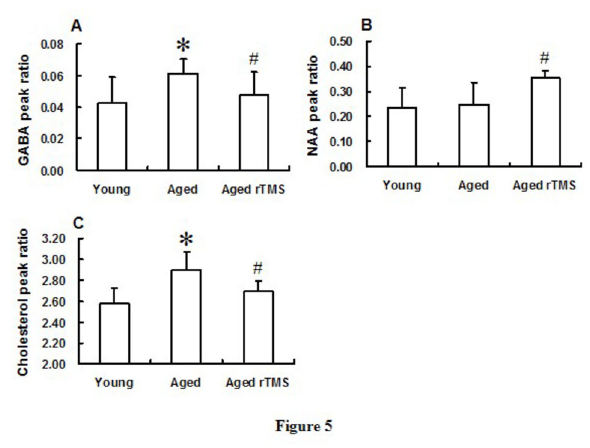
Figure S1. Changes of metabolites were observed during aging. Plot data of above indicated that metabolites of Ala, Pho, Ser, Thr, Mal, Lac, Urea and M-In decreased significantly in aged group compared with young group (* P <0.05). Metabolites of GABA, Cit, Ole, Eic, M-Ste, Oct, Asc and Cho were significantly increased during aging (* P <0.05). The blank bars represented young mice and dark bars represented aged mice. Data were presented in mean ± SD (n=10 in young group; n=9 in aged group).